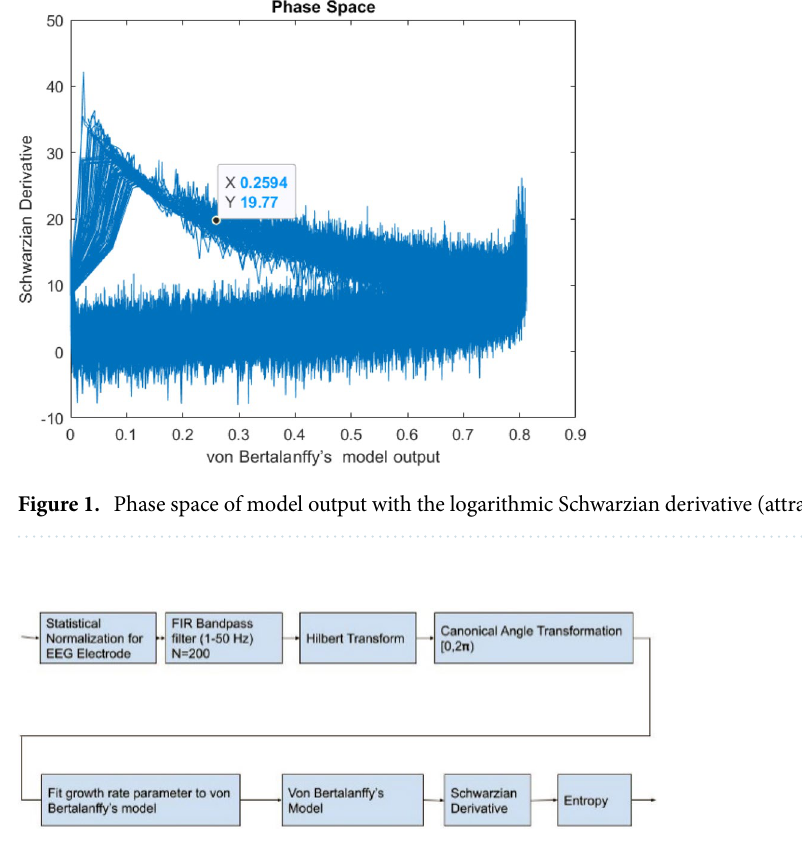
Figure 2. The general architecture of chaotic model for each electrode associated with Schwarzian